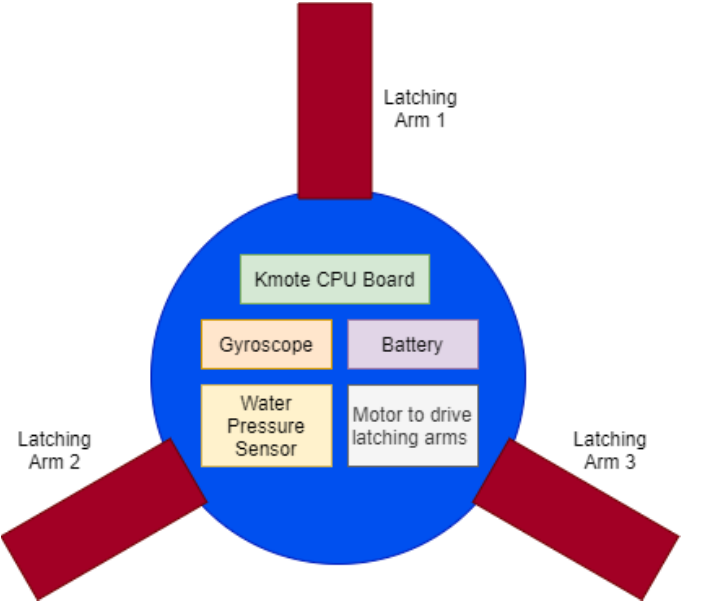
Figure 62. The prototype of TriopusNet sensor node. Adapted from